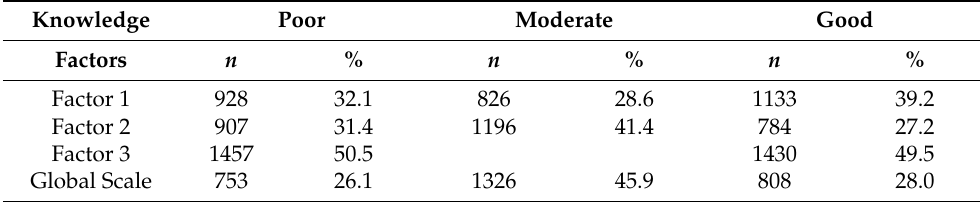
Table 9. Classification of the respondents’ level of knowledge for each